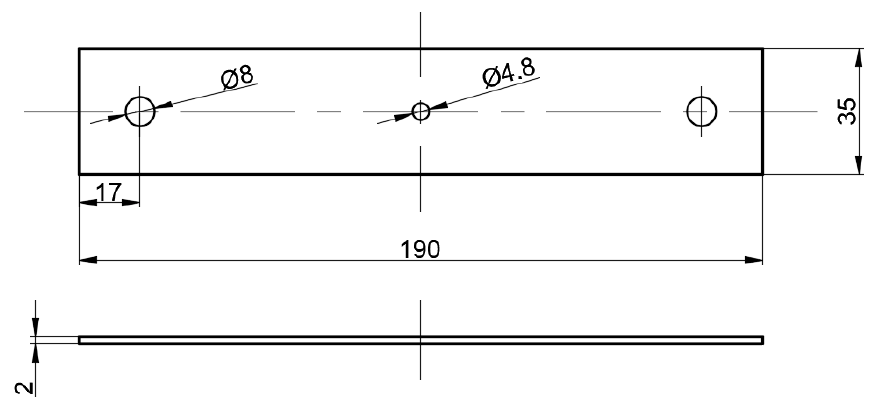
Figure 1. Geometry of the specimens for fatigue test. All of the dimensions are in mm.